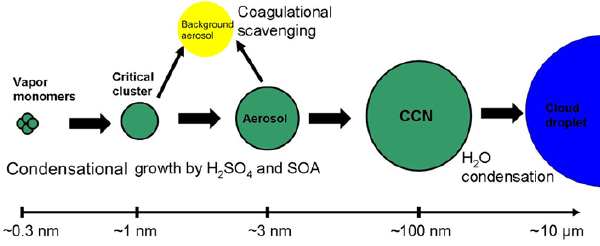
Fig. 1. Dynamics of new particle formation from vapor to cloud droplet. Two competing processes determining the fate of freshly formed atmospheric nuclei are condensational growth (eventually forming CCN) or coagulational scavenging, which results in the loss of the